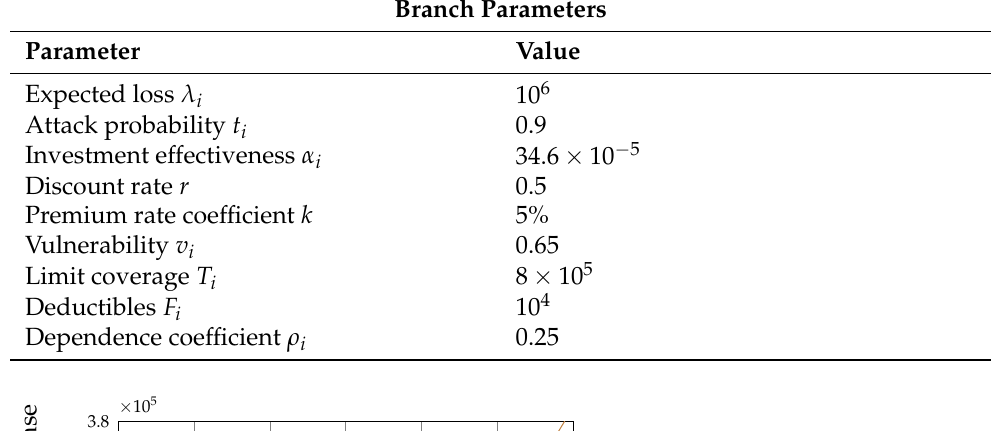
Table 3. Parameters adopted for the generic i th branch.